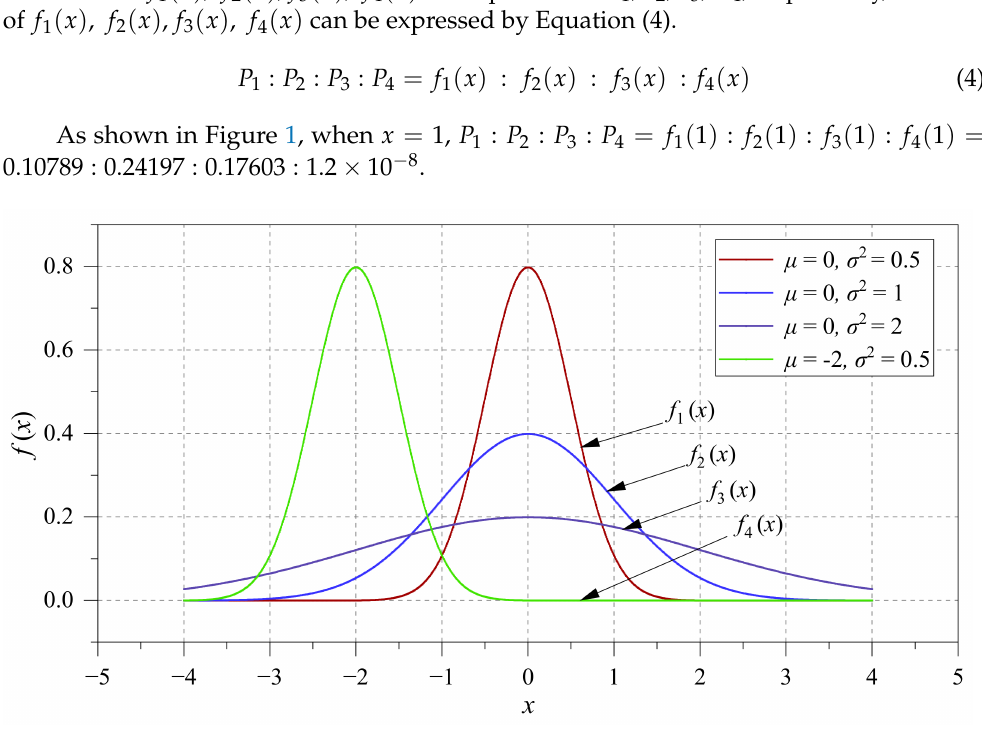
Figure 1. Four kinds of Gaussian probability density function.